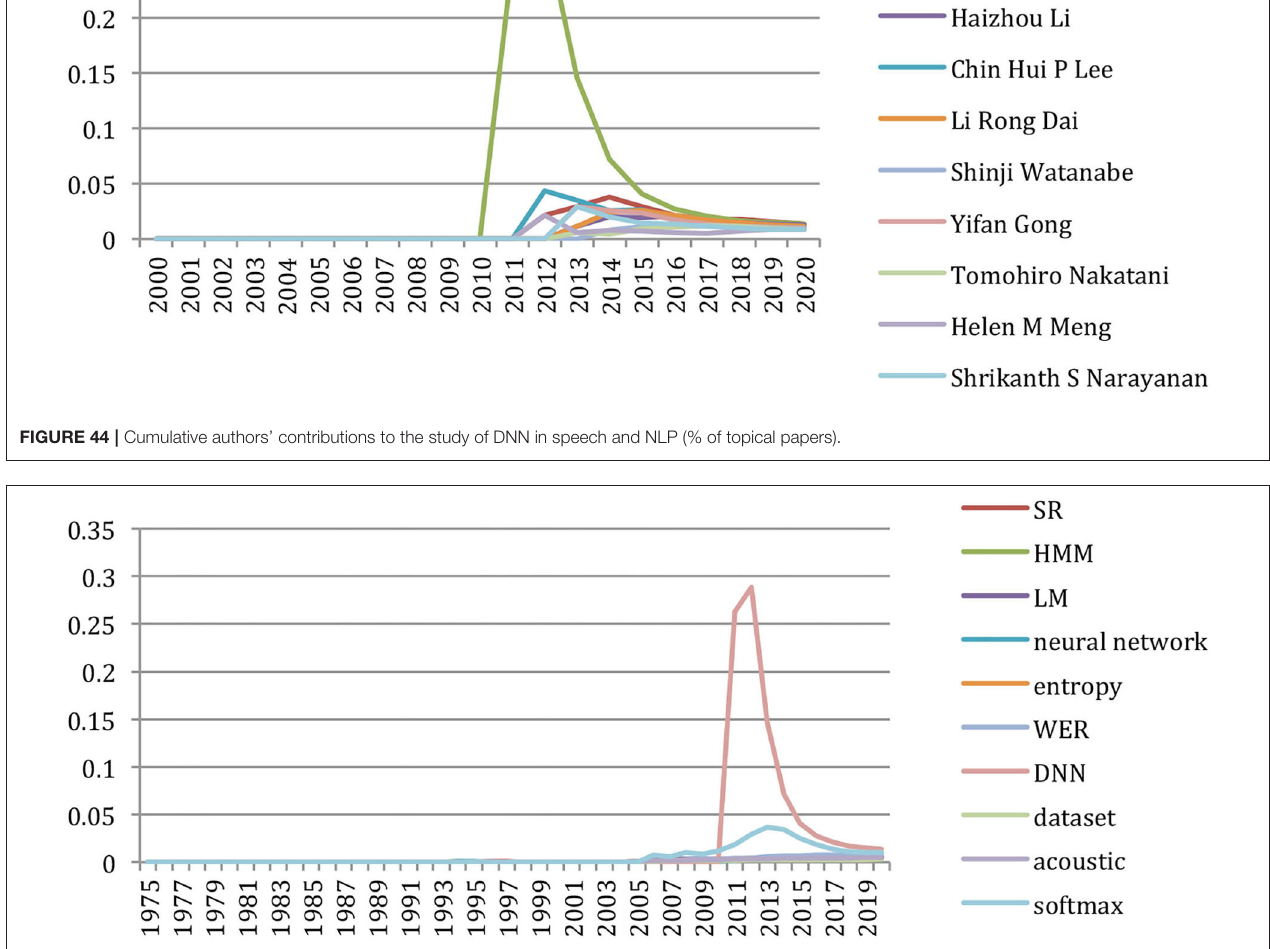
FIGURE 45 | Main contribution areas for Dong Yu (% of topical papers).